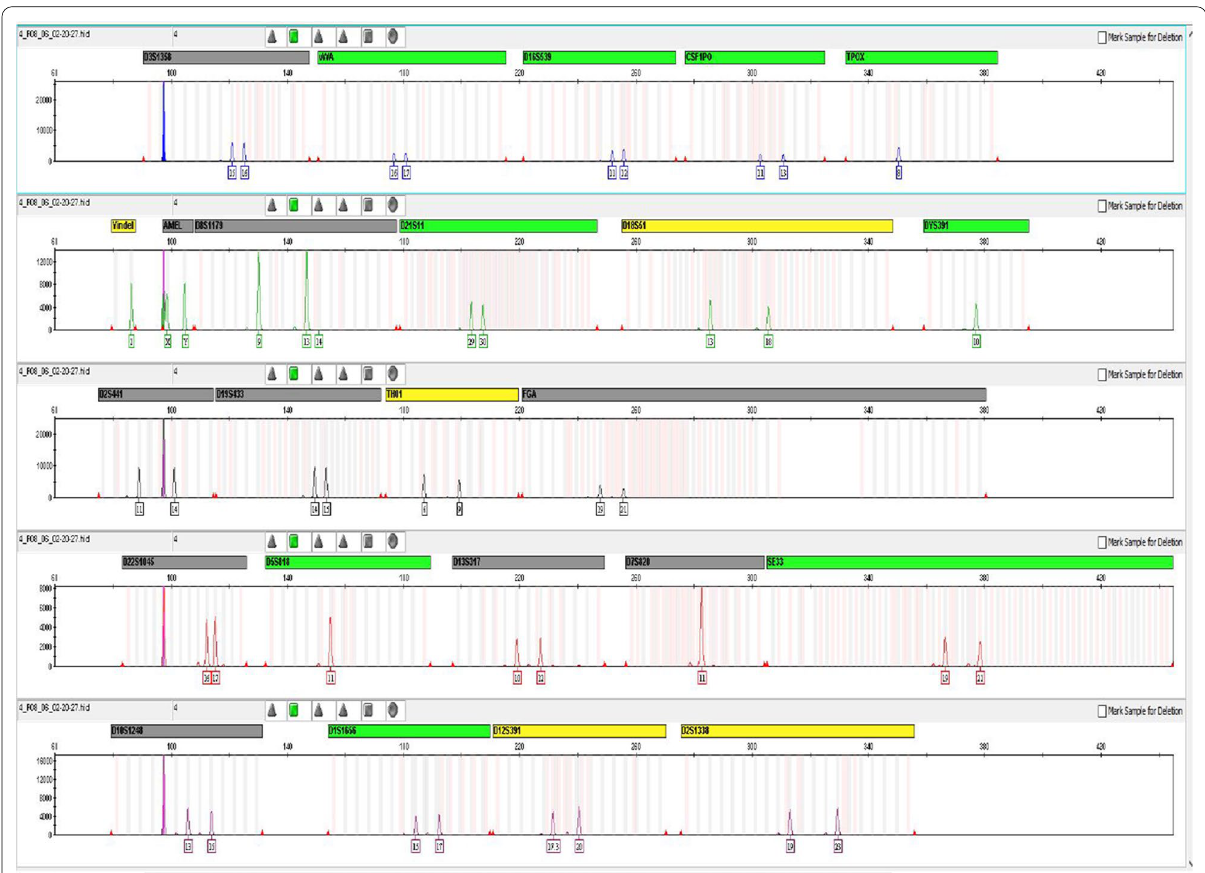
Fig. 8 DNA profile of blood stain in washed nylon fabric at 60 °C extracted by spin colon-based extraction method (QIAamp DNA Mini Kit)